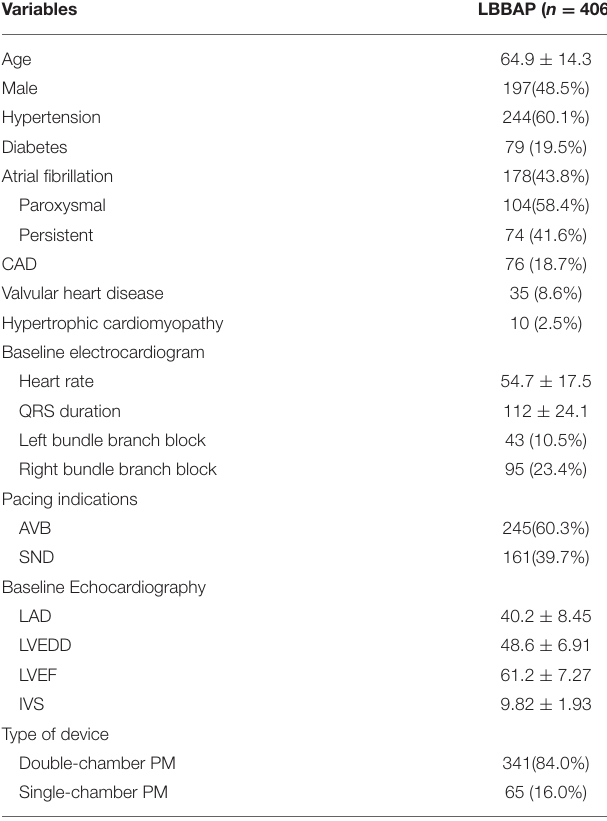
TABLE 1 | Baseline clinical and demographic features of patients attempting